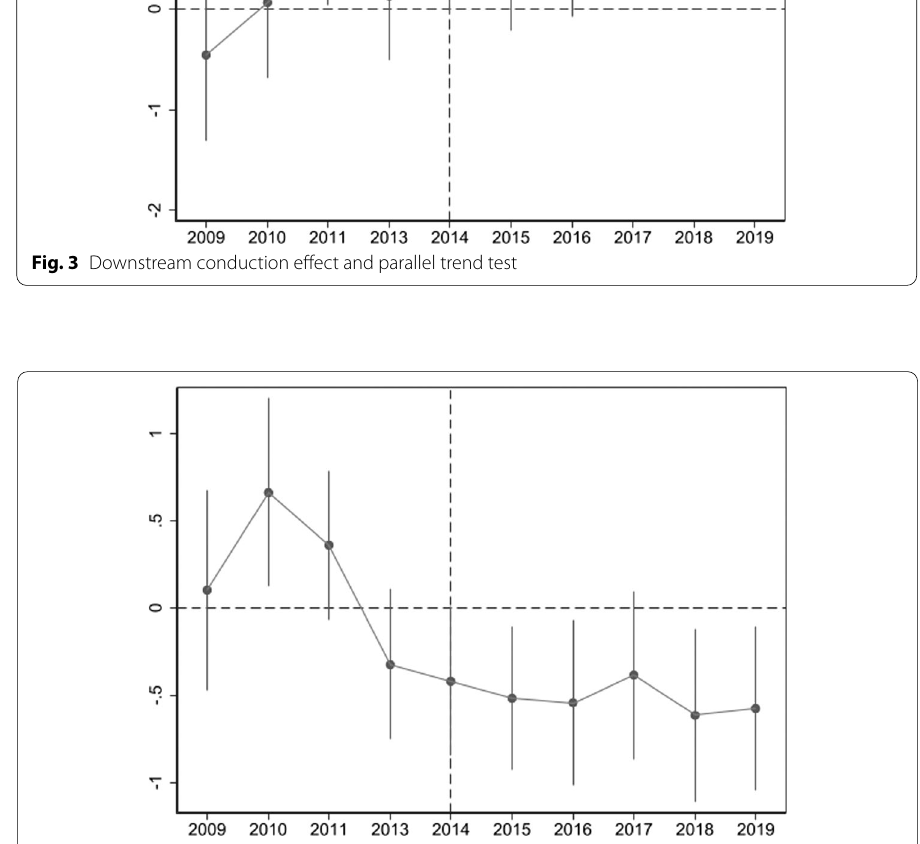
Fig. 4 Upstream conduction effect and parallel trend